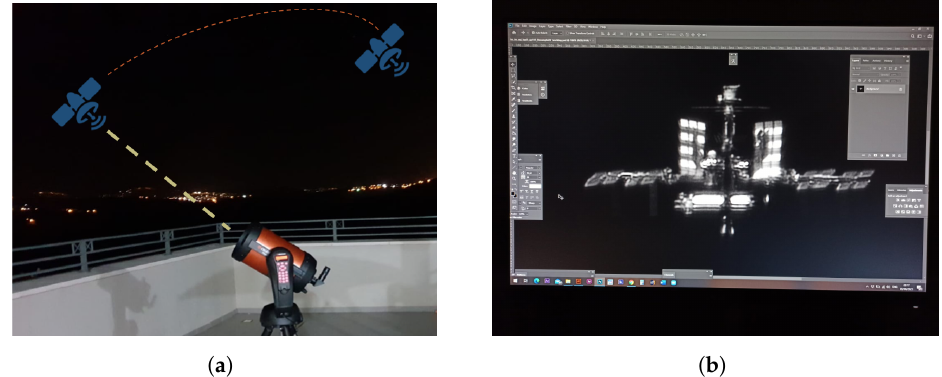
Figure 5. ( a ) Abstraction of a ground station–satellite communication link. ( b ) The ISS as captured from our ground station; shot taken by Michael Tzukran [22] on 3 June